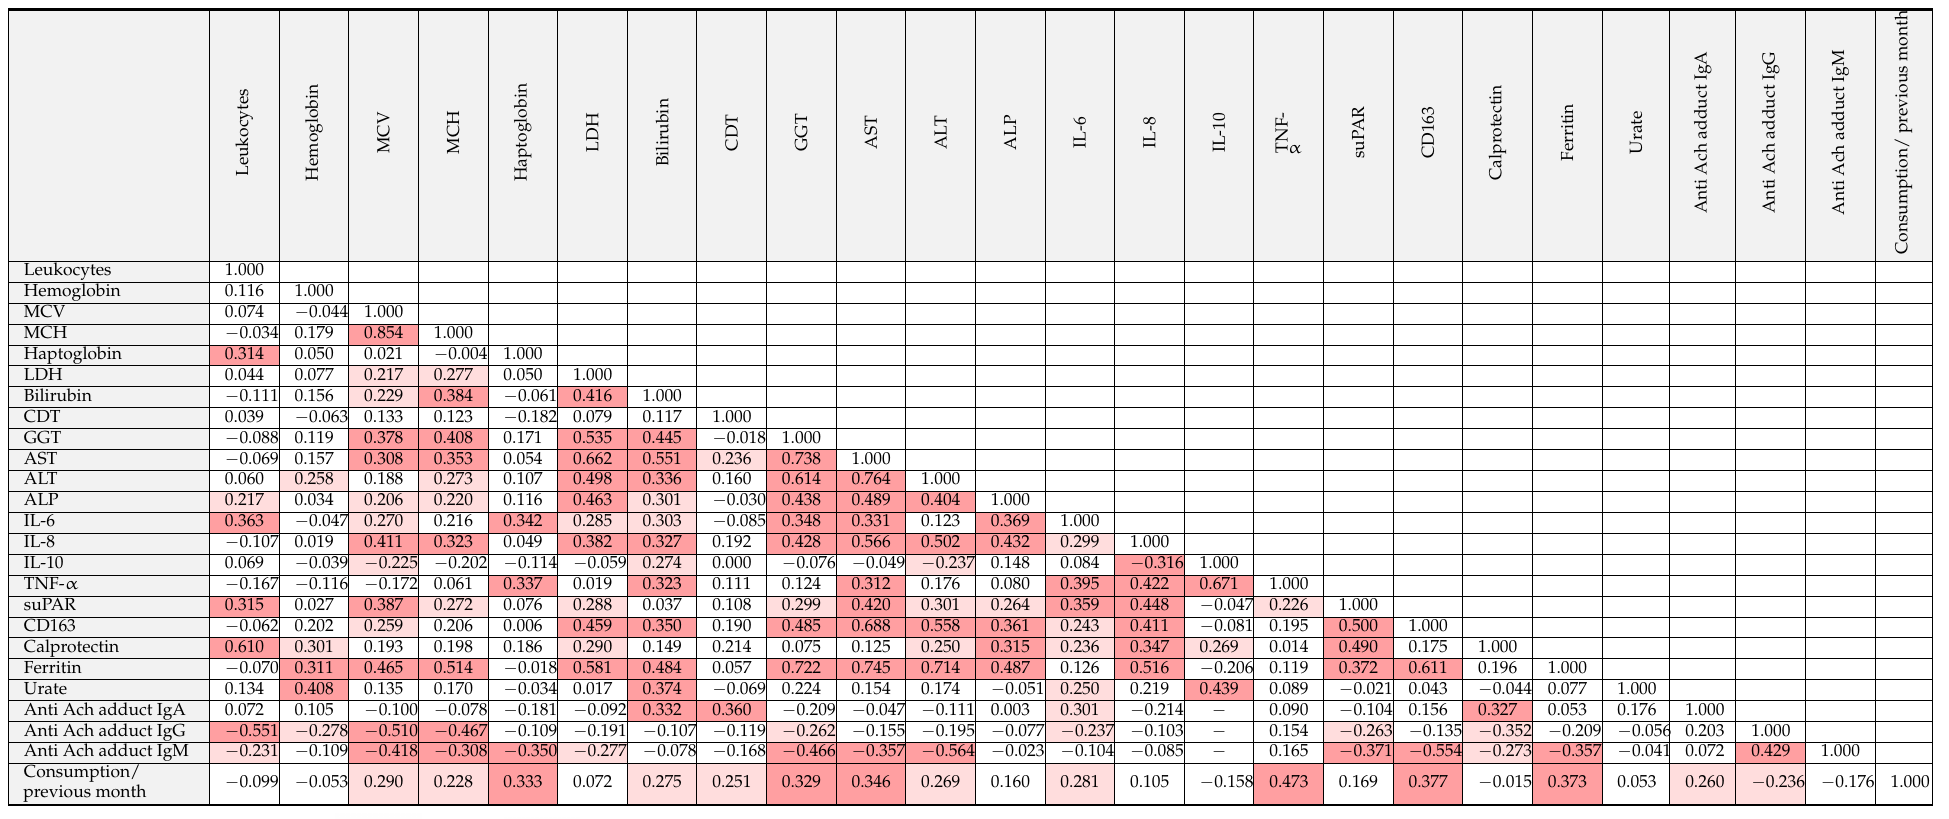
Table 2. Correlations between the study